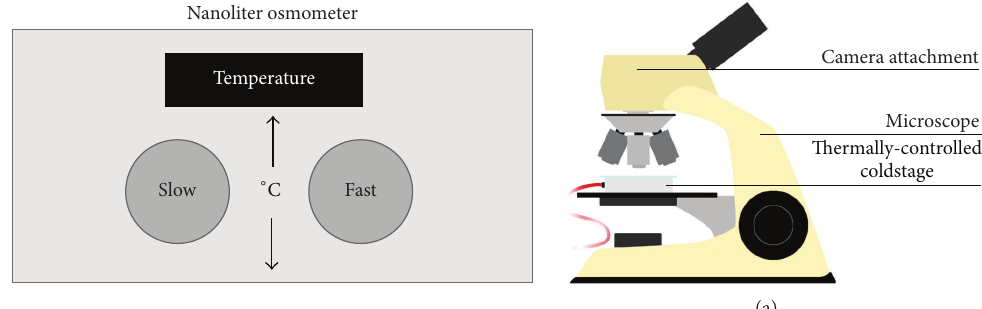
Figure 3: Instruments used to determine thermal hysteresis. The operator uses the nanoliter osmometer to carefully control the temperature of the cold plate: knobs are used to sensitively increase and decrease temperatures. A solution droplet placed in immersion oil is observed for ice crystals. Following flash freezing, the solution is melted until a single ice crystal remains to visually determine the melting and freezing temperature.